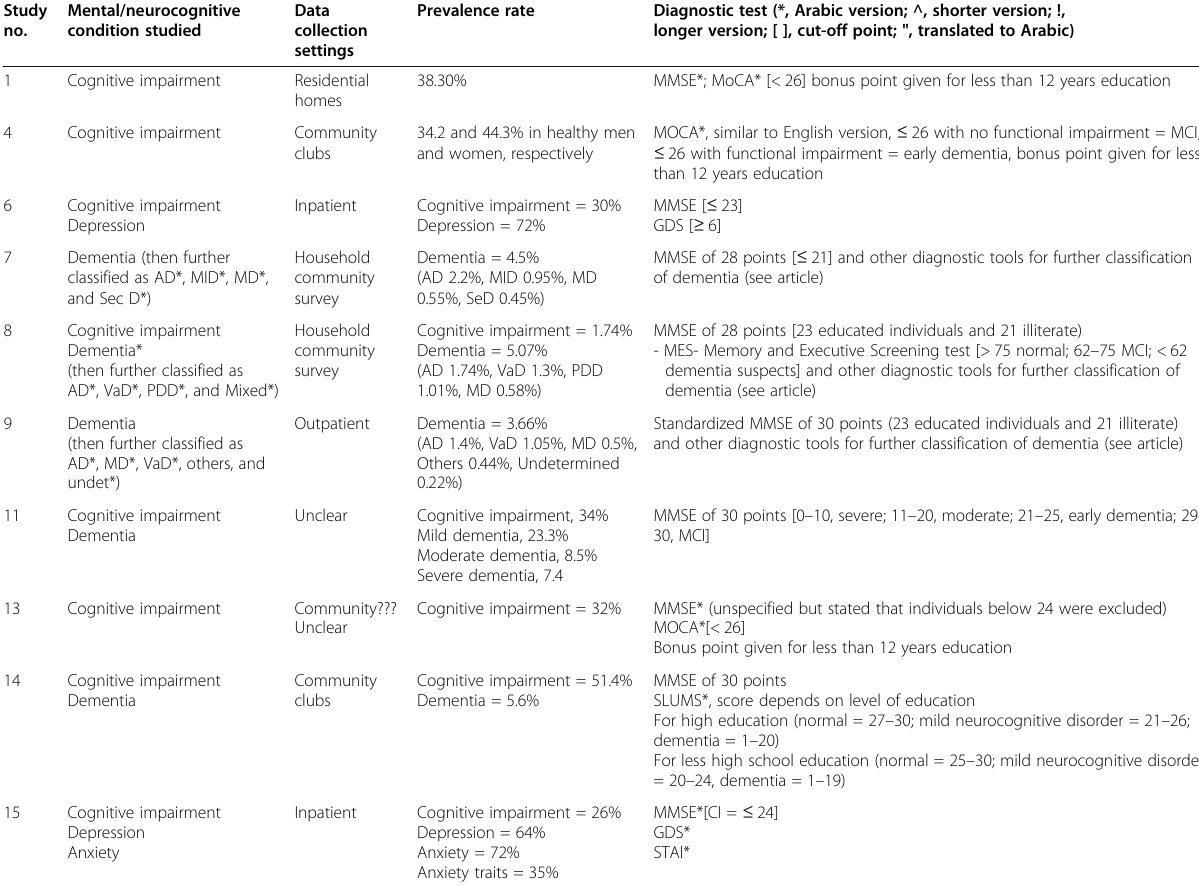
Table 5 Prevalence of cognitive impairment and dementia Study